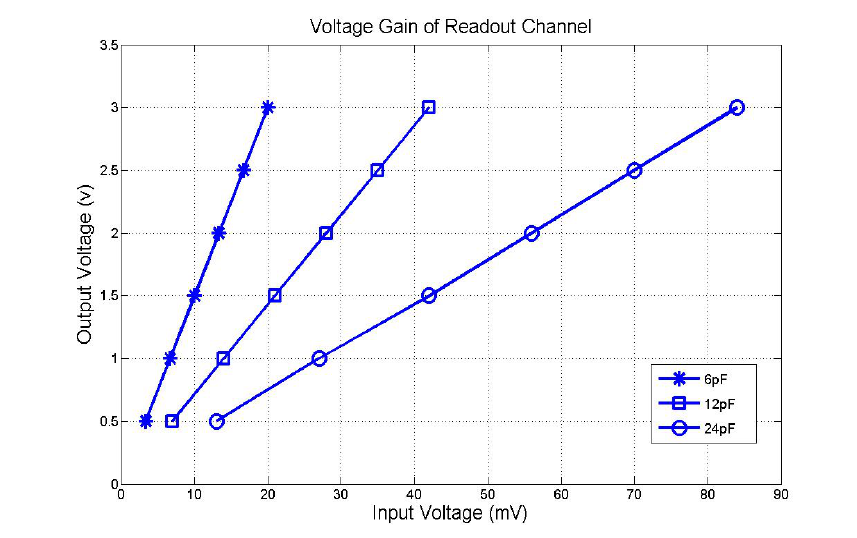
Figure 10. Measured voltage gain of proposed